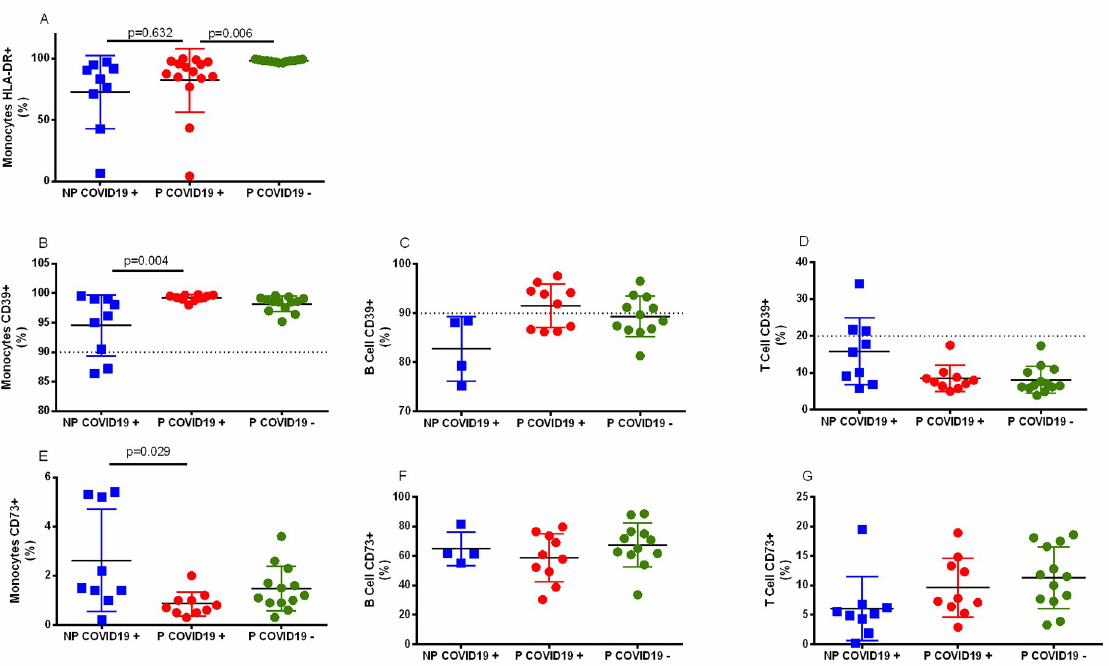
Fig 1. Surface marker on leucocytes. Whole blood cells were immunophenotyped as described in the methods. The results are expressed as the mean ± SD. Significance value was p < 0.05. Kruskal–Wallis and Dunn’s multiple comparisons tests were calculated. Non-Pregnant COVID-19 positive (NP-COVID-19+, n = 4–9). Pregnant COVID-19 positive (P-COVID-19+, n = 10–15). Pregnant COVID-19 negative (P-COVID-19-, n = 12–13). The dotted line indicates the percentage of monocytes, B cells and T cells that constitutively express CD39